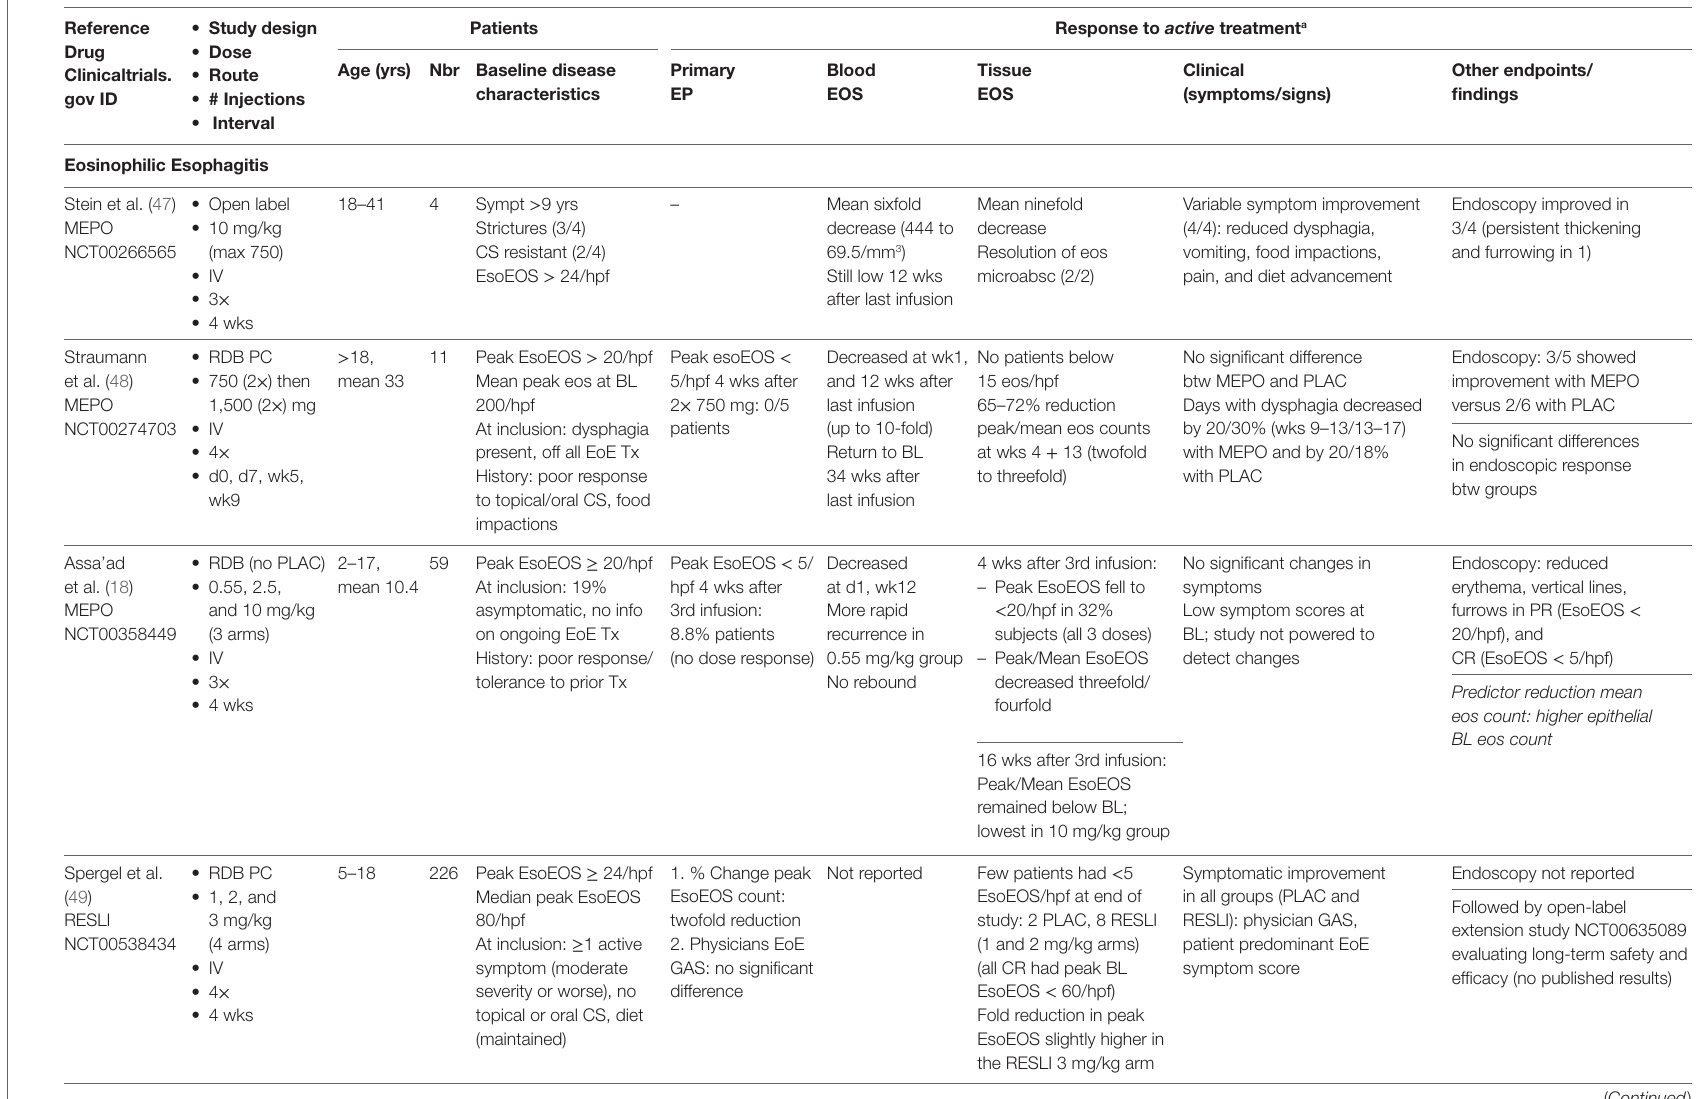
TABLe 2 | Clinical trials evaluating anti-IL-5 antibodies in mucosal eosinophilic disorders other than asthma. Reference